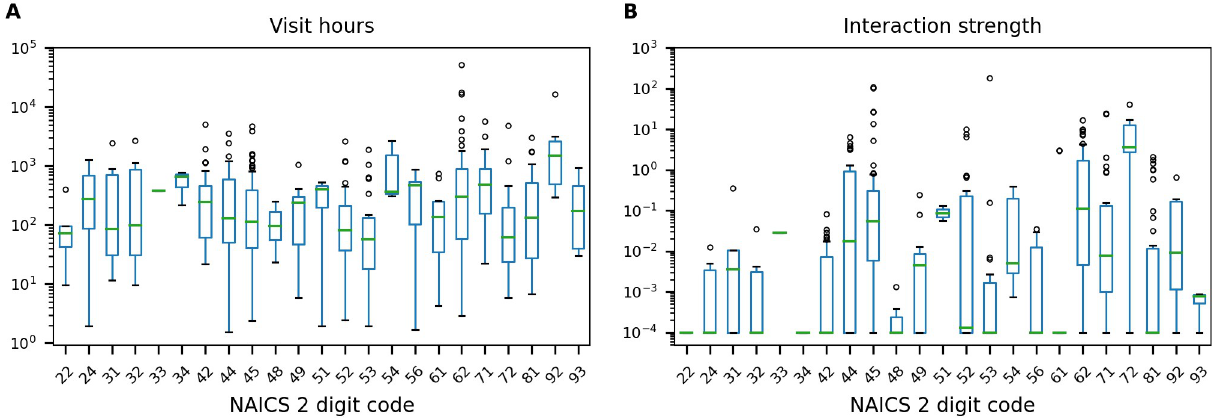
Fig 9. Traffic measured using visit-hours and interaction strength at POIs. POIs grouped by 2-digit NAICS code using data from March 30th. A: Visit-hours. B: Interaction strength, κ p